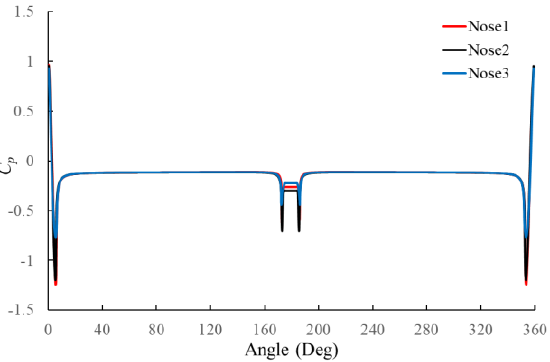
Figure 11. Comparison of the pressure distributions on trains with different nose shapes. The asymmetry of the separation points leads to the difference in the wake panel lengths on the upper surface and the lower surface of the train. Thus, the interpolative